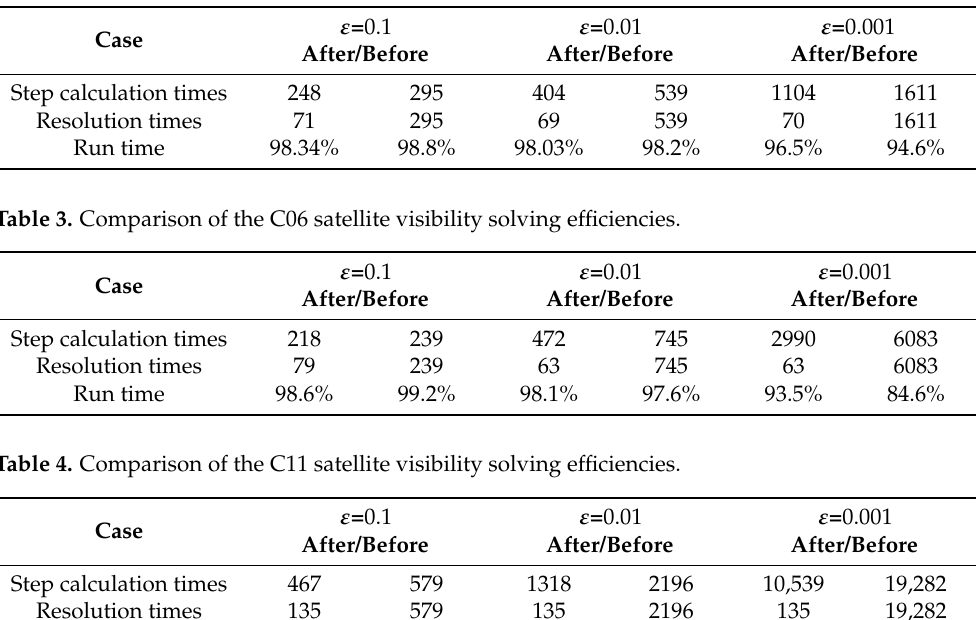
Table 2. Comparison of the C01 satellite visibility solving efficiencies.